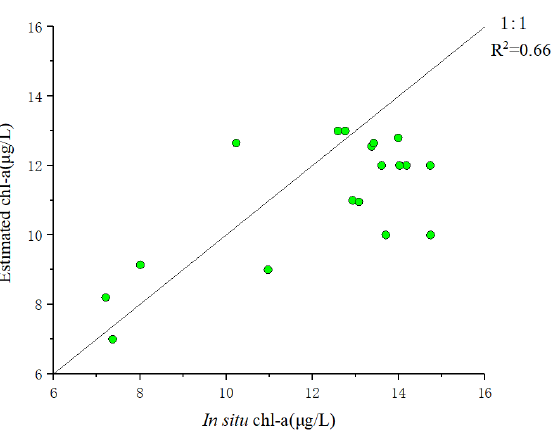
Figure 11. Scatter plot of in situ versus sentinel-2-derived Chl-a concentrations.